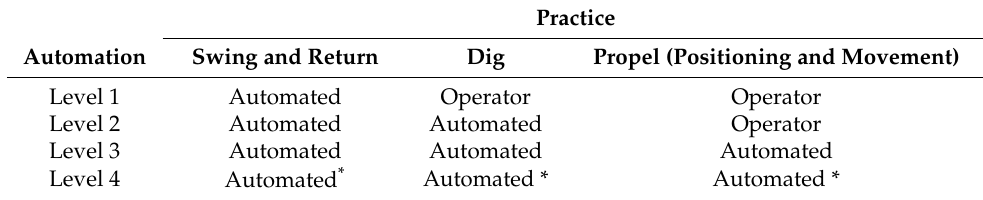
Table 1. Automation scenarios.